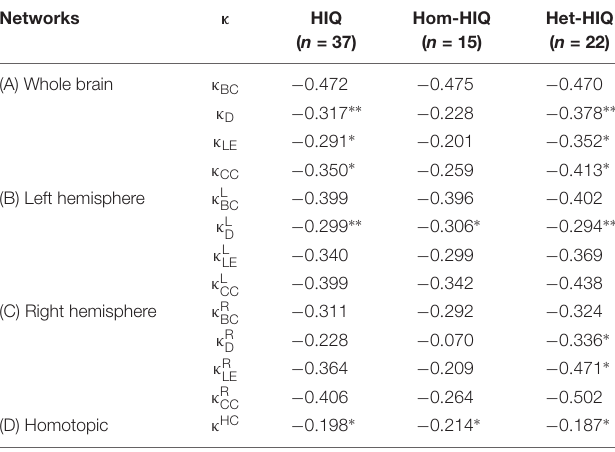
TABLE 2 | Hub disruption indices ( κ ) in HIQ, homogeneous HIQ (Hom-HIQ), and heterogeneous HIQ (Het-HIQ) groups measured in whole brain networks (A), left and right hemispheres networks (B and C), and between homotopic regions (D). Networks